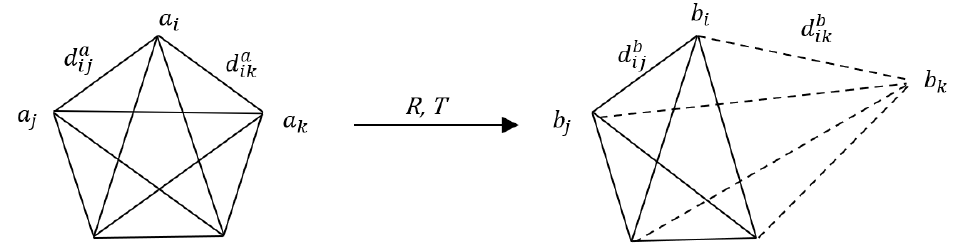
Figure 4. Schematic of wrong point pair.